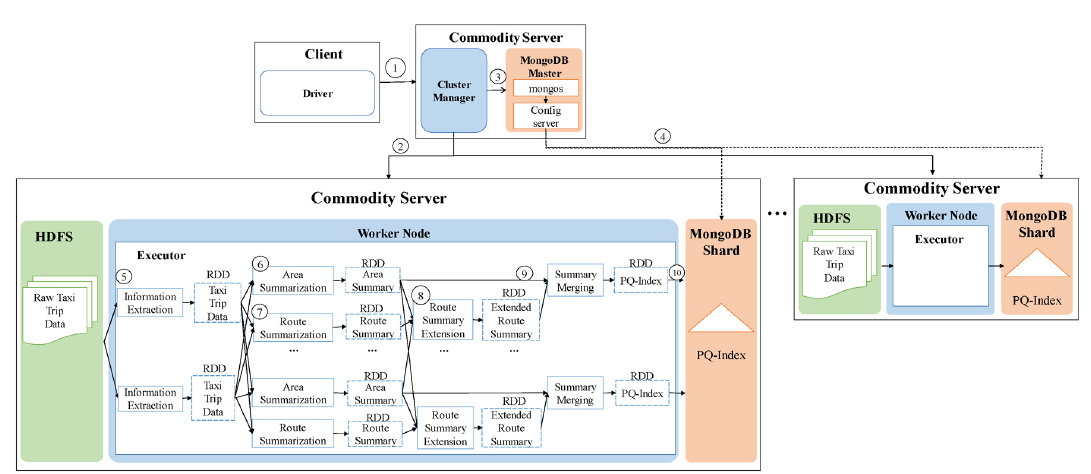
Figure 12. A PQ-index.